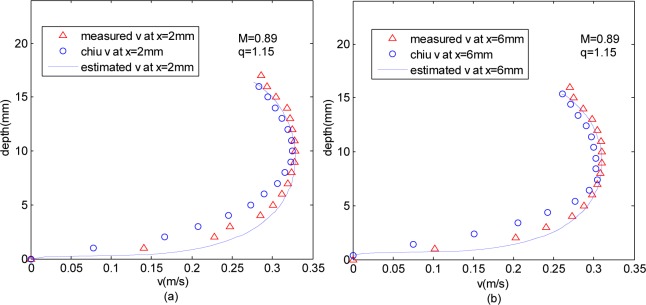
Comparison of different methods (a) comparison at x = 2mm (b) comparison at x = 6mm.